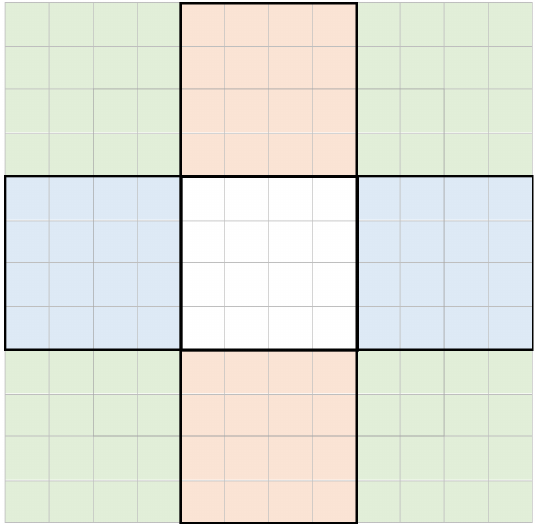
Figure 7. The construction of a 12 × 12 stencil with diagonal halo region in the shared memory. The white cells represent 4 × 4 leaf cells in a leaf node. The light blue cells represent the halo cells of the stencil taken from the X + and X − directions. The light red cells represent the halo cells of the stencil taken from the Y + and Y − directions. The light green cells represent the diagonal halo cells of the stencil taken from diagonal directions in a ’neighbor of neighbor’